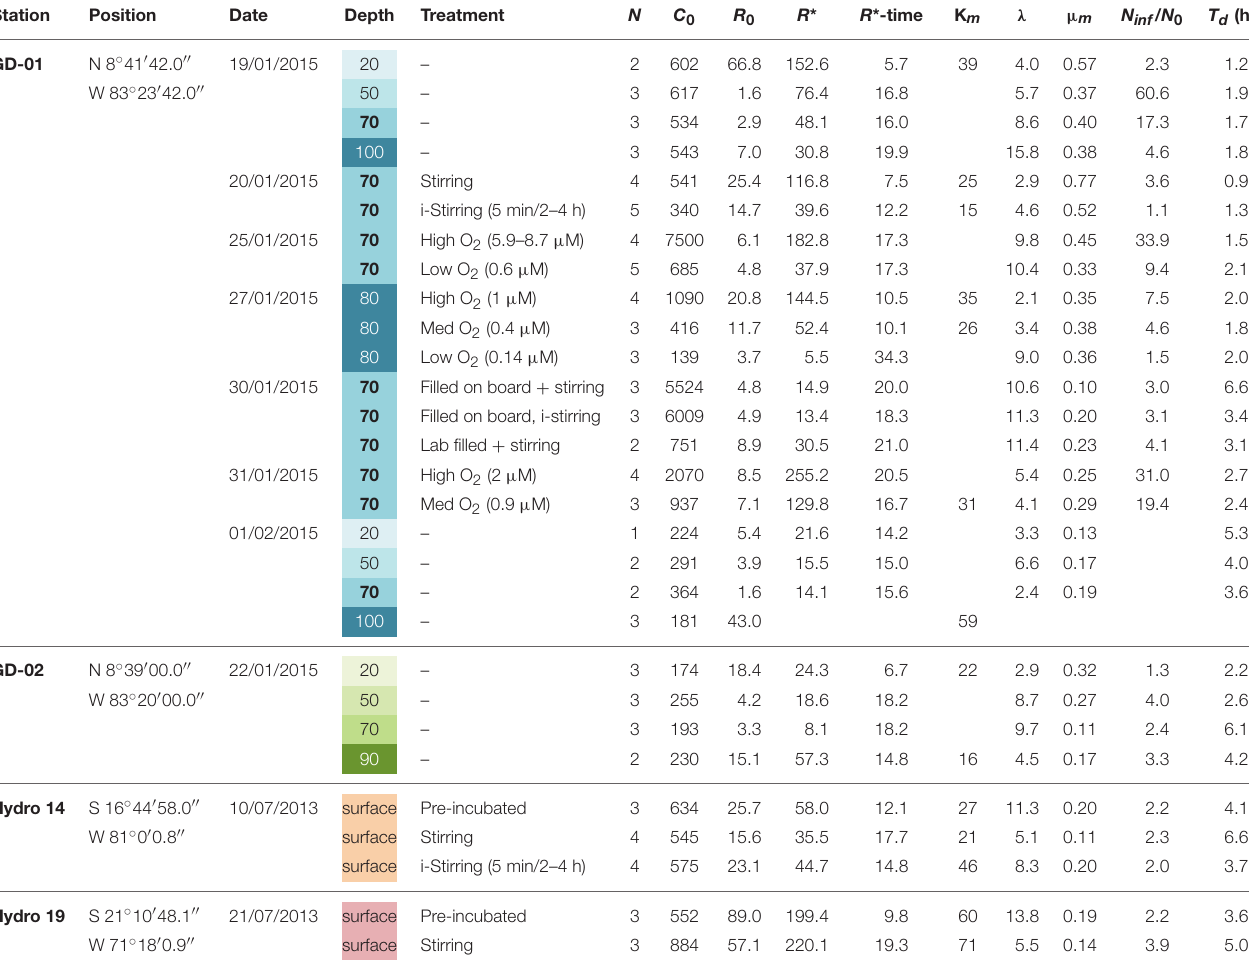
TABLE 1 | Stations, dates, depths, and data of the samplings and experiments carried out in Golfo Dulce (Costa Rica) and in the ETSP. Station Position Date Depth Treatment